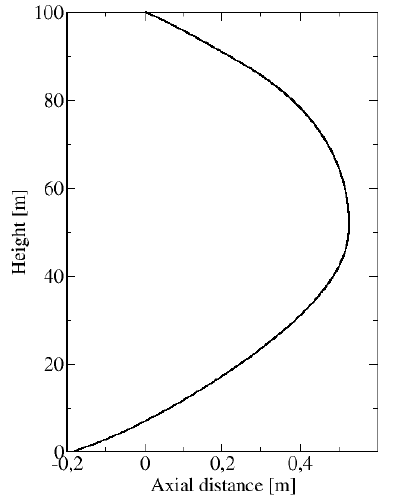
Figure 12. Trajectory of an ice chunk released at an azimuthal angle of 270 degrees, side view.